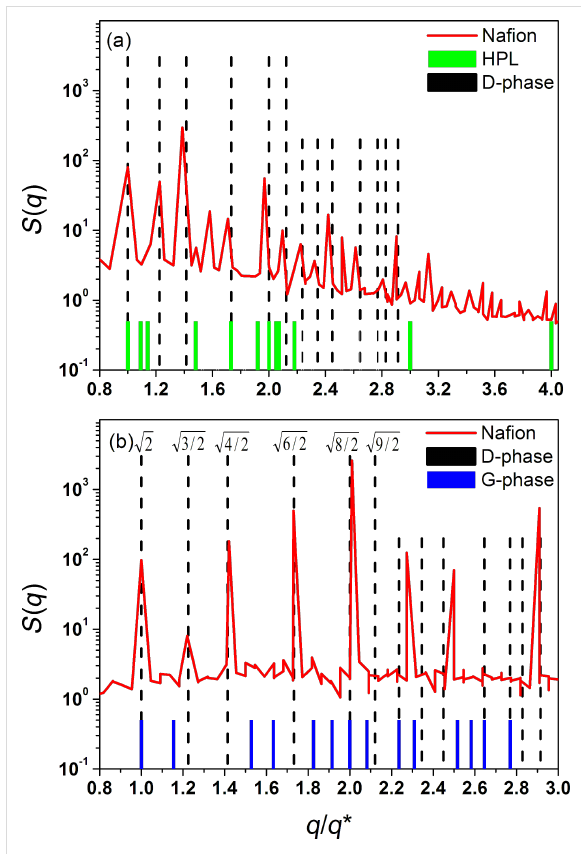
Figure 4: Partial structure factors, S ( q ), of the water phase (red line) calculated for (a) the 524,864-atom system and (b) the 4,198,912-atom system at λ = 10 and T = 298 K. These functions are compared to those known for a perfect structure, including hexagonally perforated lamellae (HPL), double diamond (DD) and double gyroid (DG). The vertical lines correspond to the expected peaks for these structures [66-69]. The S ( q ) functions are plotted versus q / q *, where q is the wave number and q * is the position of the first, most intensive maximum of the S ( q ). The peaks are shown at each magnitude of the scattering vector , where h , k , and l are the Miller indices associated with the allowable reflections. (a) The solid (green) and dashed (black) vertical lines correspond to the expected harmonics for P 6 3 / mmc (consistent with the HPL structure) and (consistent with DD structure) crystallographic symmetries. (b) The vertical lines correspond to the expected harmonics for (consis- tent with DD structure) and (consistent with DG structure) crystal- lographic